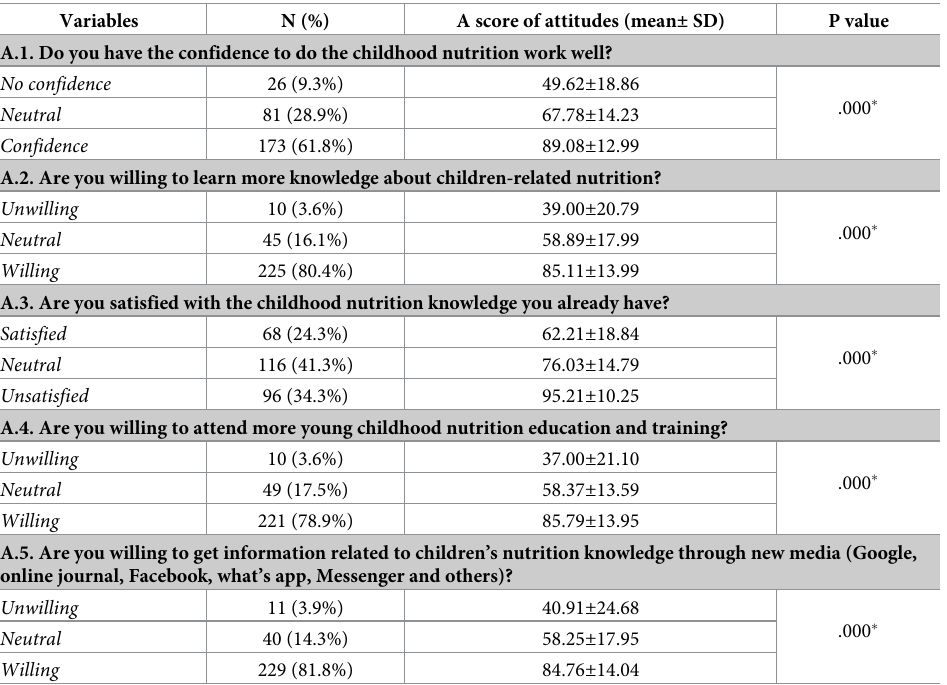
Table 3. The average score of each dimension in nutrition-related